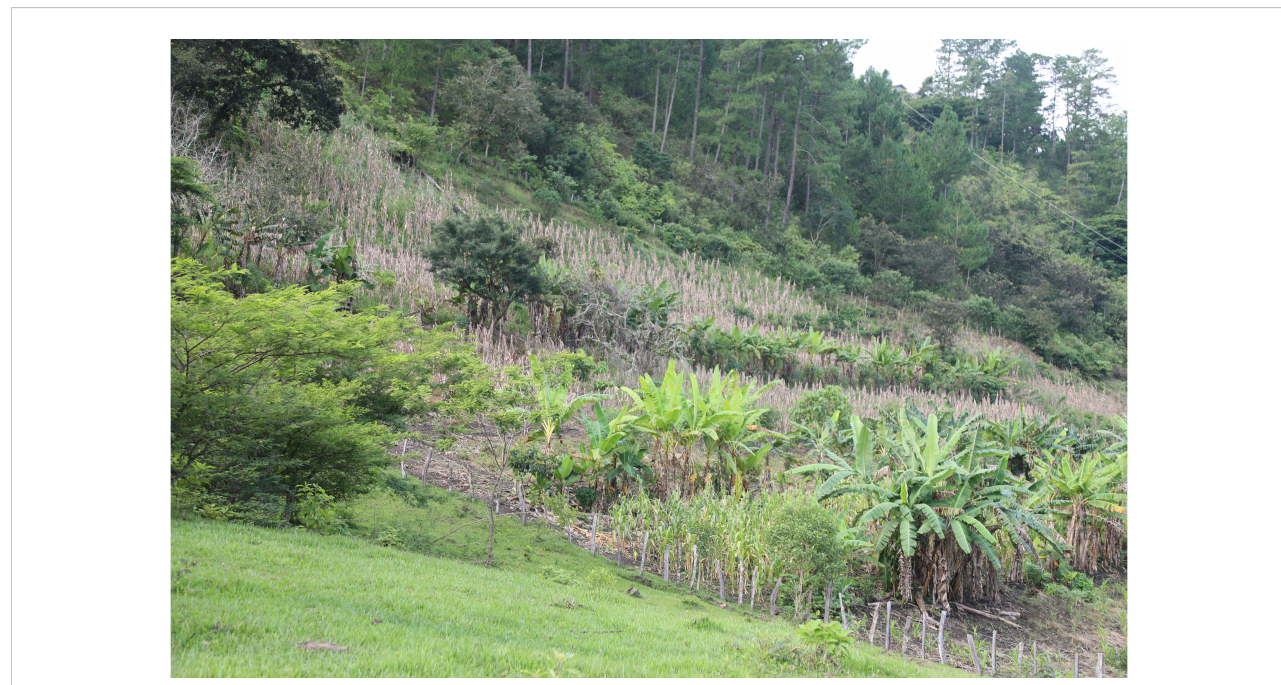
FIGURE 5 A MIAF (Milpa Intercalada con Arbolos Frutales, Milpa intercropped with fruit trees) agroforestry system with banana trees in Ocosingo, Chiapas,